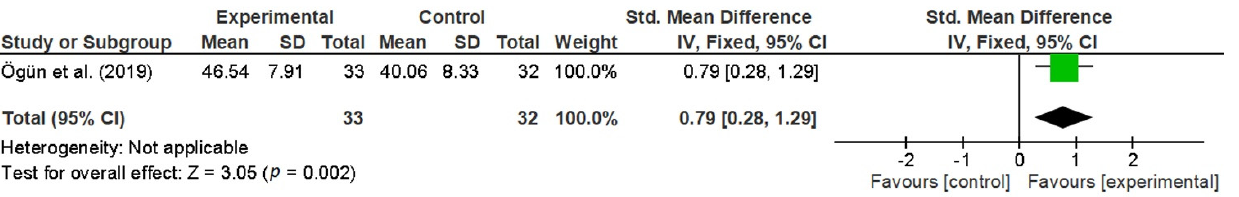
Figure 8. Pooled standardized mean differences and overall effect size (95% CI) on the FMUE test immediately after the intervention.